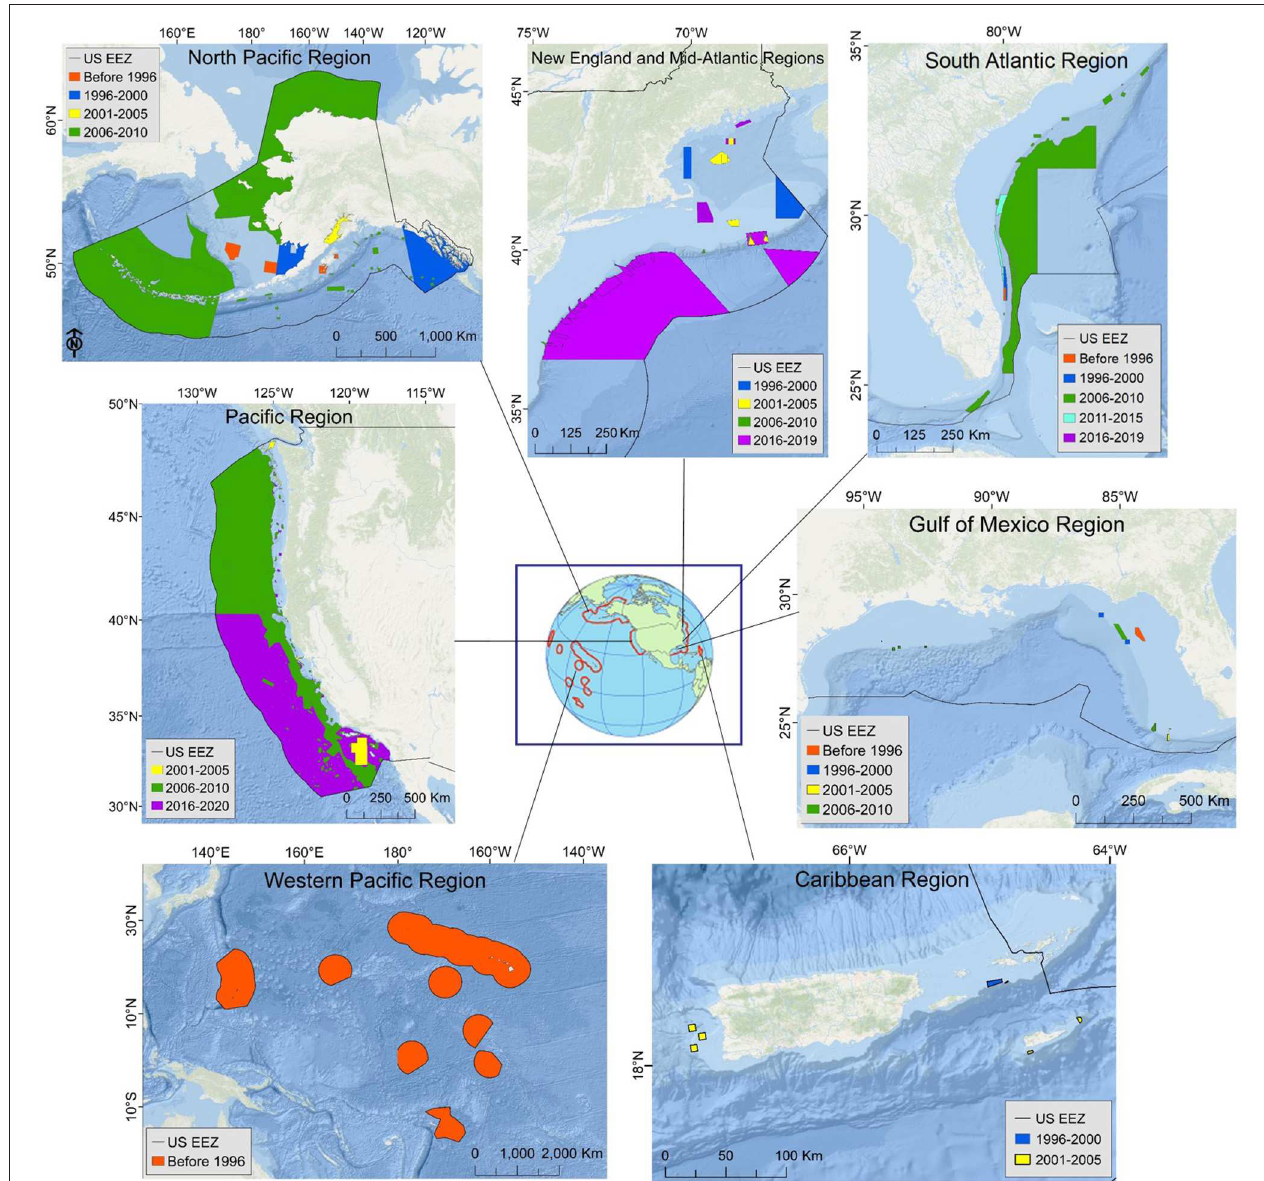
FIGURE 1 | Restrictions on bottom-trawling, usually considered the most substantial threat to deep-sea coral and sponge habitat, in the U.S. exclusive economic zone (EEZ) as of January 2020. Protections are illustrated by year of implementation and grouped as taking effect before 1996 (the year essential fish habitat was introduced; red polygons), or between 1996–2000 (dark blue), 2001–2005 (yellow), 2006–2010 (green), 2011–2015 (light blue), or 2016–2019 (purple). The Pacific Region map legend includes 2020 because the Pacific Fishery Management Council approved trawl restrictions in 2018 that were enacted on 1 January 2020. Note the different geographic scales used for each region. The New England and Gulf of Mexico Fishery Management Councils approved additional protections in 2018 that were yet to be enacted by the time of publication, so are not shown